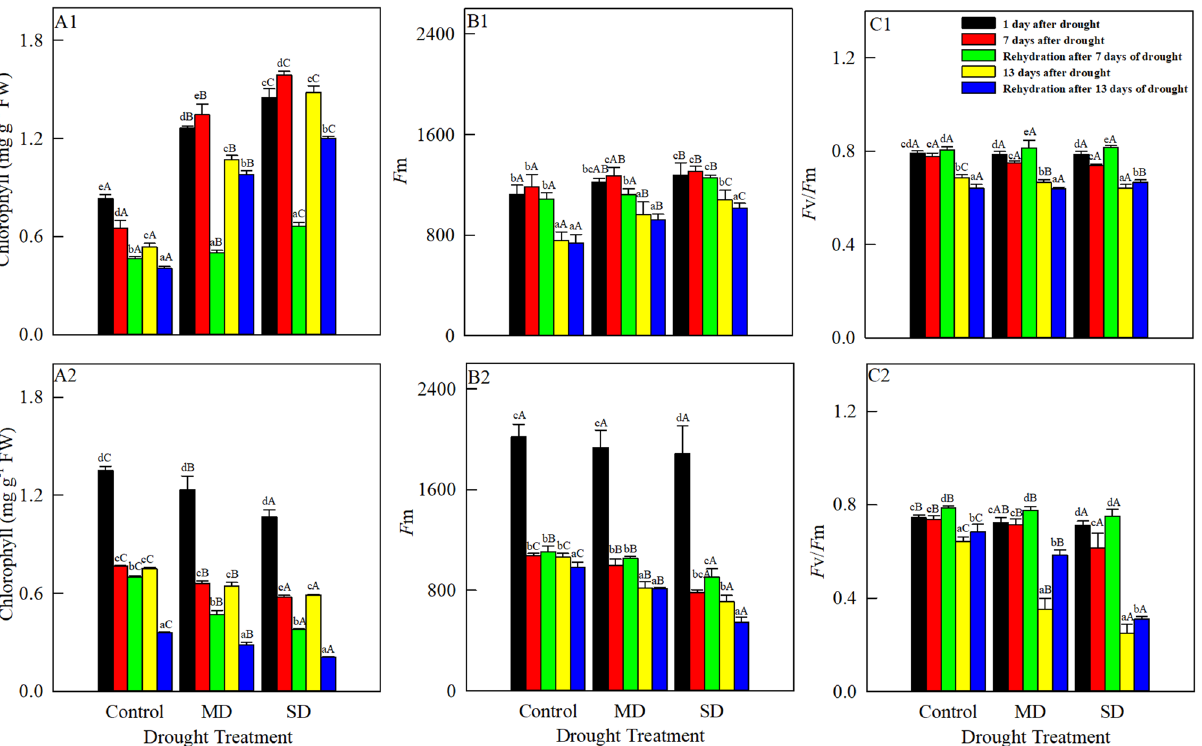
Figure 1. Changes in chlorophyll content, F m and F v/ F m of A. squarrosum ( A1 , B1 , C1 ) and S. viridis ( A2 , B2 , C2 ) under drought stress (August 1, 7, 13) and rehydration (August 8, 14). Different lowercase letters indicate significant differences among days for the same treatment. Different capital letters indicate significant differences among drought treatments for the same on 14 August. RWC of A. squarrosum under severe drought was highest (88.2%) on 8 August, but RWC of S. viridis reached its highest value in the control (93.1%). With increasing drought duration, the malondialdehyde content in the control of A. squarrosum (Fig. 2B1) first decreased (from 1 to 7 August) and then increased (from 7 to 13 August), but the content under moder- ate and severe drought increased continuously. The content decreased with increasing drought intensity on 1 August. However, the contents under moderate drought on 7 and 13 August were significantly higher than those in the control and under severe drought. The malondialdehyde content of S. viridis (Fig. 2B2) increased with increasing drought duration and stress, and reached the highest level under severe drought on 13 August (2.714 mmol g −1 DW). Although the malondialdehyde content in the control of A. squarrosum increased after rehydration on 8 August, the contents in both species on 8 and 14 August were lower than those before rehydration. Membrane permeability of the two species (Fig. 2C1, C2) increased with increasing drought duration and stress. On 1 August, membrane permeability of A. squarrosum (28.2%) and S. viridis (22.2%) reached its lowest values in the control, and these values were significantly lower than those under moderate and severe drought. After re-watering on 14 August, rehydration reduced membrane permeability of A. squarrosum in the control, but permeability reached its highest level (63.3%) on 8 August, and this was significantly lower than the value before rehydration. On 8 and 14 August, membrane permeability of A. squarrosum under moderate and severe drought and of S. viridis under all treatments was lower than that before rehydration. Changes in the activity of antioxidase. With increasing drought duration, peroxidase activities of both species (Fig. 3A1, A2) first decreased and then increased, except that the activity in A. squarrosum under severe drought increased continuously. Peroxidase activity of S. viridis was the largest (136.073 10 3 U g −1 DW min −1 ) in the control on 1 August, 1.15 times and 1.50 times, respectively, the values under moderate and severe drought. After re-watering on 8 and 14 August, peroxidase activity of A. squarrosum was higher than that before rehydra- tion, whereas S. viridis showed decreases after both re-hydrations. SOD activities of both species (Fig. 3B1, B2) increased with increasing drought duration and sever- ity. From 1 to 13 August, their activities were significantly higher under severe drought than in the control and under moderate drought. On 13 August, SOD activity of S. viridis was highest under severe drought, at 173.071 10 3 U g −1 DW h −1 , which was 1.13 and 1.38 times the value in the control and under moderate drought, respectively. SOD activity of A. squarrosum after rehydration was higher than that before rehydration, and its activity increased with increasing drought stress. On 8 August, rehydration increased SOD activity in S. viridis , but its activity decreased below that before rehydration on 14 August.